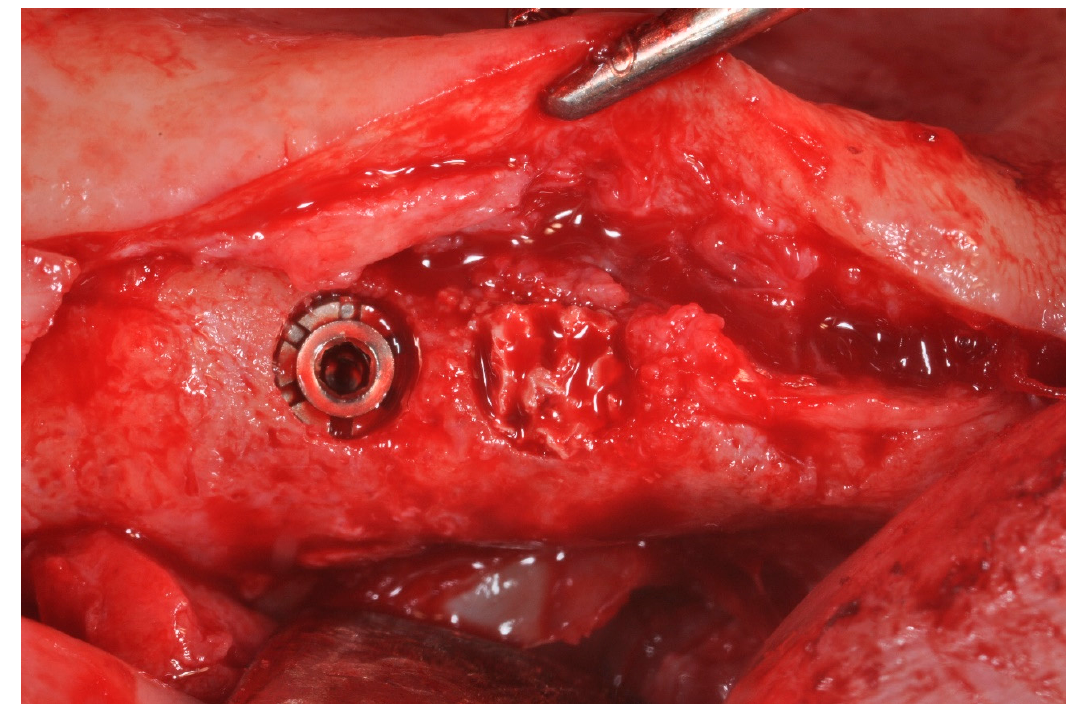
Figure 3. HA scaffold placement in bone defect.